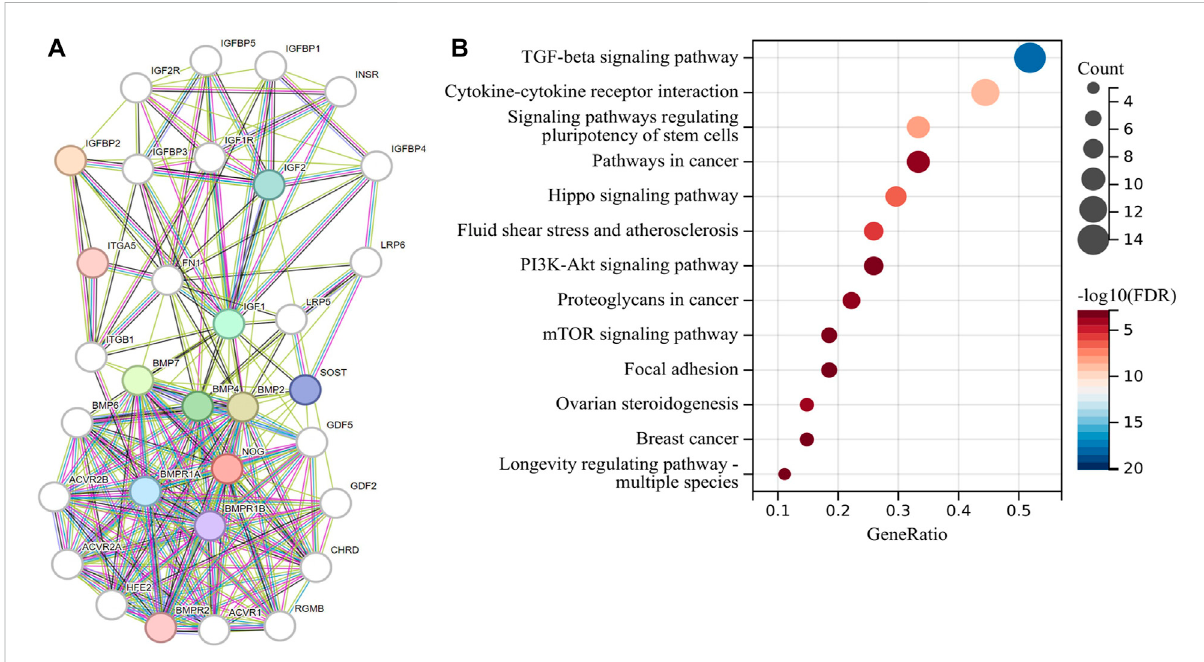
FIGURE 4 Risk model-related gene function enrichment analysis. (A) Gene regulatory network of 32 genes related to the risk model and (B) KEGG enrichment analysis of this regulatory network.